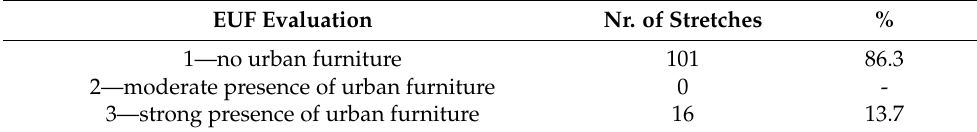
Table 9. Existence of urban furniture (EUF).